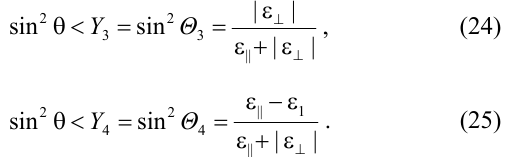
Figure 3: The spectral dependences of main dielectric permittivities of the I type HMM on the basis of multilayered Ti O /Ag 3 5